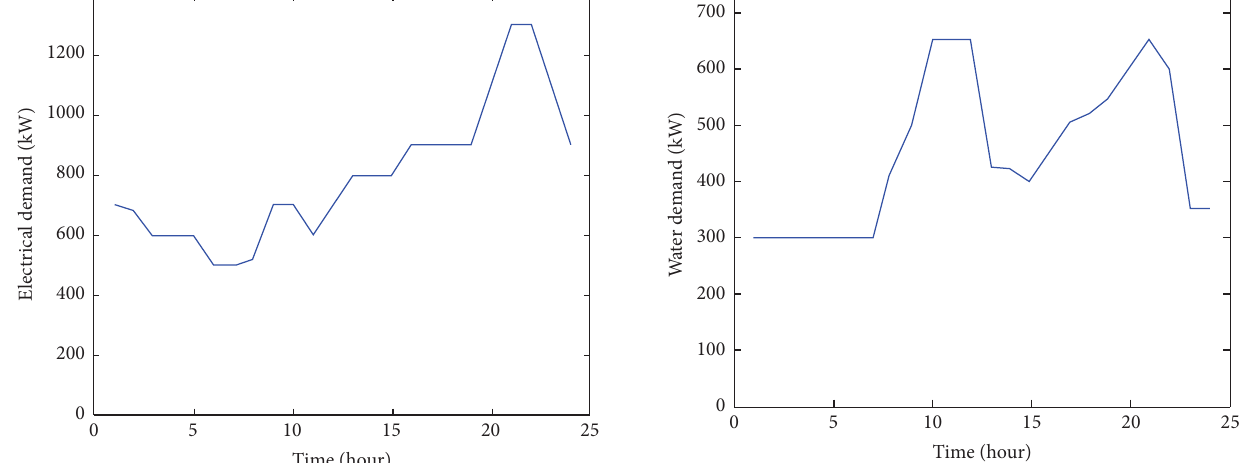
Figure 2: Electrical demand of the energy hub system.